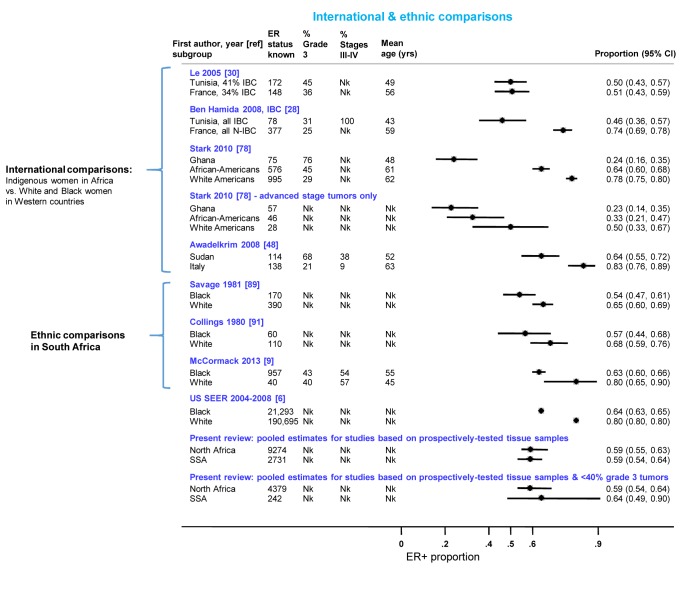
International and ethnic comparisons in the proportion of ER+ disease.IBC, inflammatory breast cancer; N-IBC, non-inflammatory breast cancer; Nk, information not given in the original paper; SEER, Surveillance, Epidemiology, and End Results (SEER) Program of the National Cancer Institute, US (data downloaded from [6] using the same methods as in [9]); SSA, sub-Saharan Africa.